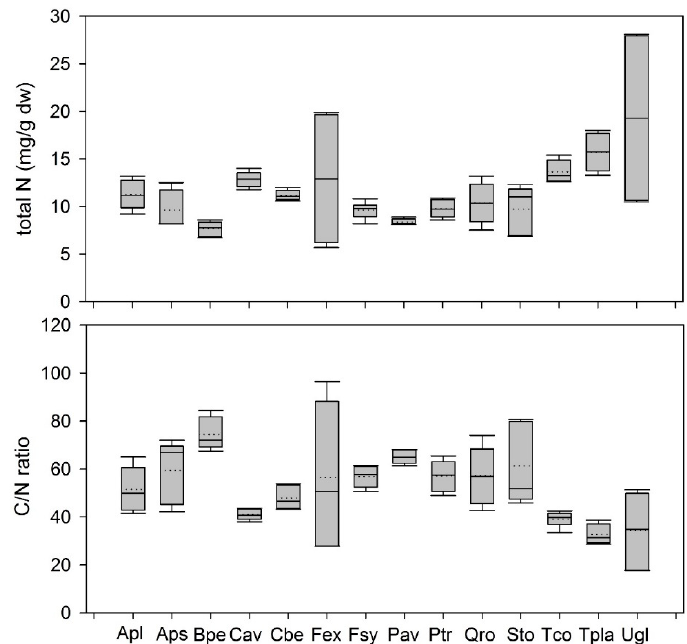
Figure 1. Total N concentration (mg/g dw) ( top ) and C/N ratio ( bottom ) in leaf litter. Boxplots show mean (dotted line) and median (straight line) for the combined years. Apl = Acer platanoides , Aps = Acer pseudoplatanus , Bpe = Betula pendula , Cav = Corylus avellana , Cbe = Carpinus betulus , Fex = Fraxinus excelsior , Fsy = Fagus sylvatica , Pav = Prunus avium , Ptr = Populus tremula , Qro = Quercus robur , Sto = Sorbus torminalis , Tco = Tilia cordata , Tpla = Tilia platyphyllos , Ugl = Ulmus glabra .